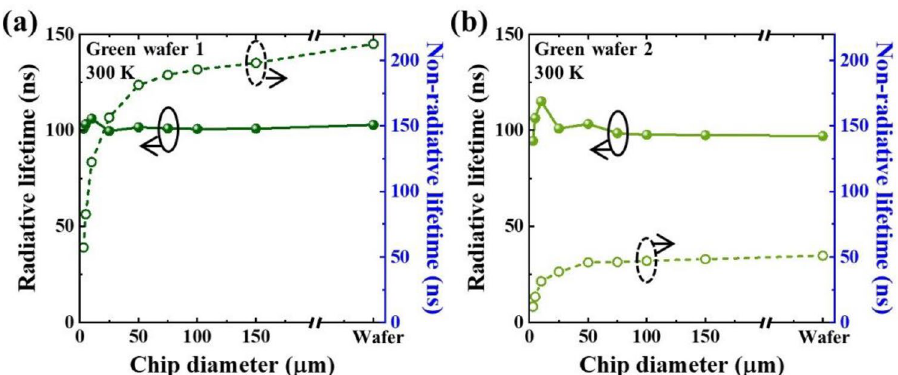
Figure 4. Chip diameter dependent radiative (solid line) and non-radiative (dashed line) carrier lifetimes for ( a ) green LED wafer 1 and ( b ) green LED wafer 2, which were calculated with measured carrier lifetimes and PL efficiencies. Radiative and non-radiative carrier lifetimes for each bare wafer is also shown for comparison.